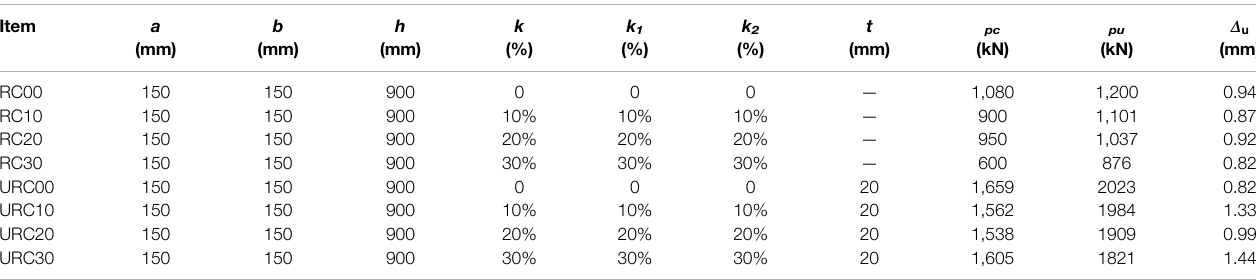
a and b denote the section size of column; h denotes the height of column k denotes the theoretical corrosion rate; k 1 and k 2 denote the actual corrosion rate of longitudinal bars and stirrups, respectively; t denotesthe thickness of UHPC jacket; p c denotesthe crackingload; p u denotes the experimental ultimate compressiveresistance; Δ u denotesthe displacement corresponding to p u